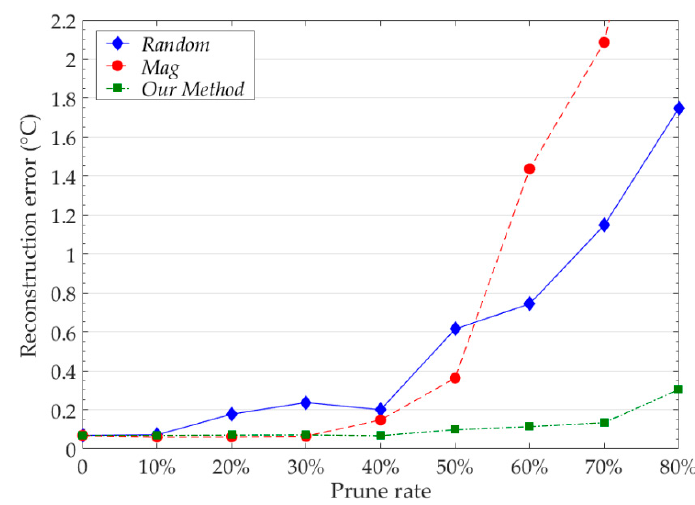
Figure 12. The pruning results of model at different pruning rates for different pruning methods. Random denotes the random pruning. Mag denotes the magnitude based pruning. The reconstruction error is the average value of all sample points in Node 7.